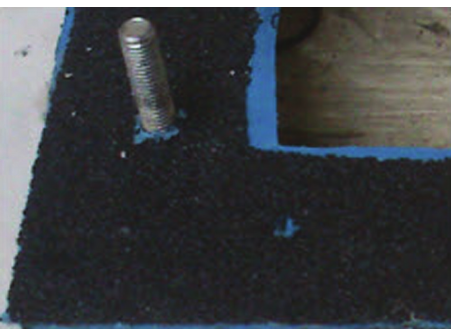
Figure 8 Sandpaper in both sides of specimens within framework.